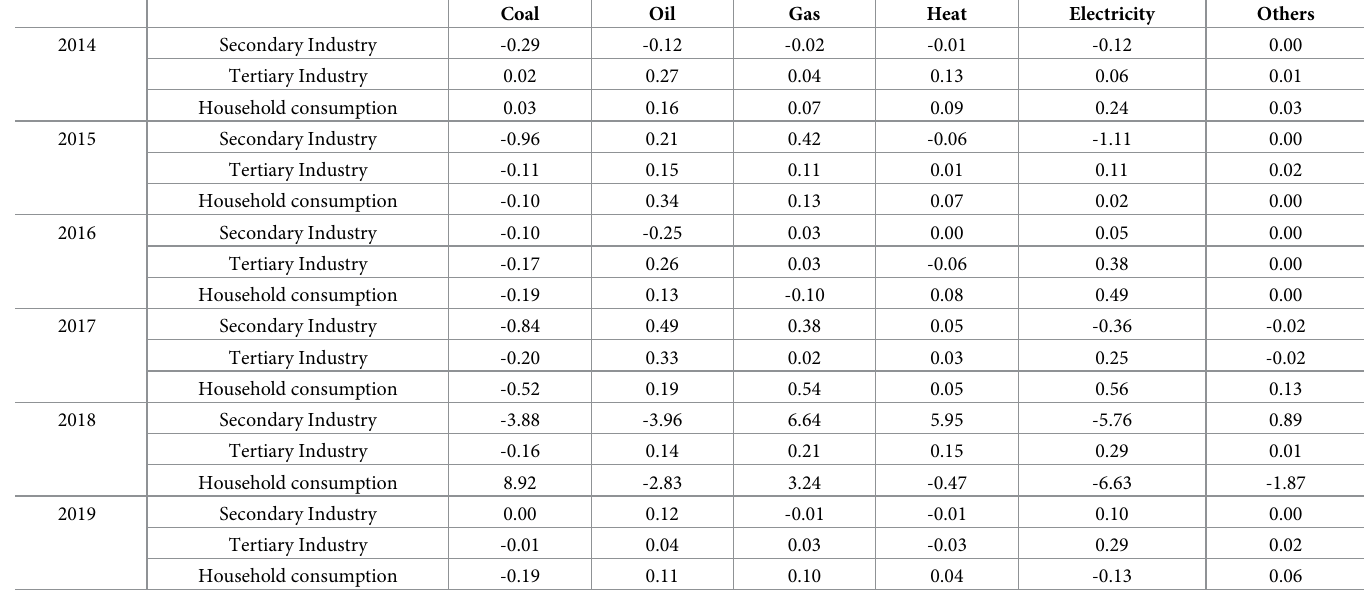
Table 8. CVSI by energy sector from 2014 to